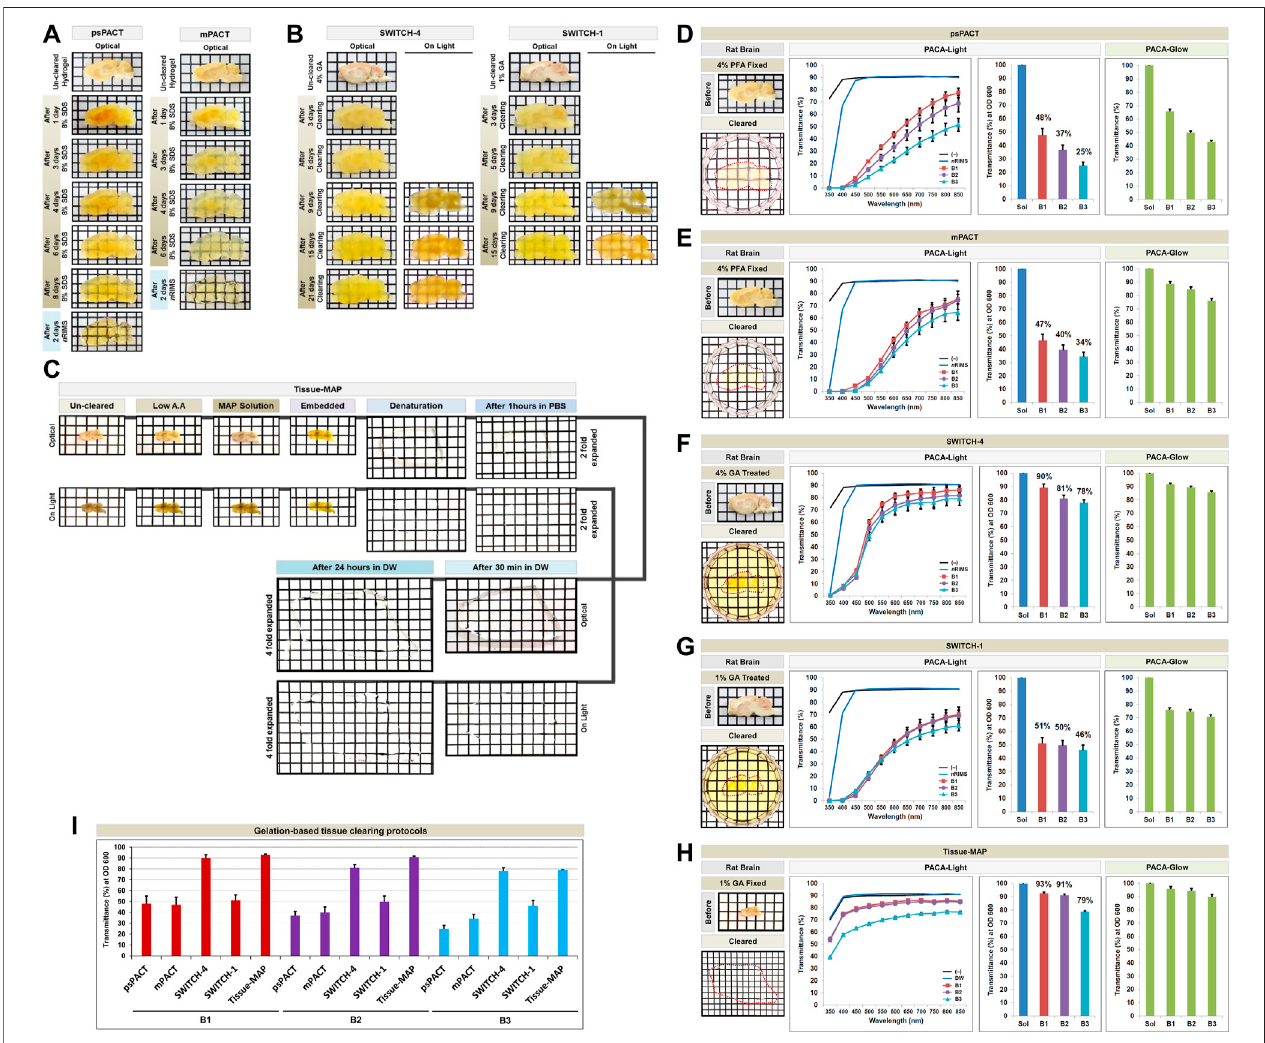
FIGURE 3 | Comparison of tissue clearing achieved with hydrogel-based tissue clearing protocols. Comparison of the optical clearing processes of PACTs (psPACT and mPACT) (A) , SWITCHs (SWITCH-1 and SWITCH-4) (B) , and Tissue-MAP (C) in rat brain samples (3 mm thickness). Comparison of clearing ef fi cacies of psPACT (D) , mPACT (E) , SWITCH-4 (F) , SWITCH-1 (G) , and Tissue-MAP (H) in rodent brain samples with both PACA-Light and PACA-Glow. Optical images showing samples after clearing (red dotted line), along with any changes in sample size upon tissue processing, are included (also Supplementary Figure S12 ). (I) Comparison of clearing ef fi cacies of hydrogel-based tissue clearing protocols. Three discs from three distinct brain regions (B1: prefrontal cortex and basal ganglia, B2: cerebralcortexandmidbrain/diencephalon,B3:cerebellum)weregeneratedandanalyzedforeachsample.Eachcolorlineandbarpointtoassessmentvaluesofempty (black)andrefractiveindexmatchingsolution(blue)ofeachprotocol,andthreedistinctregionsofthebraintheB1(square,red),B2(diamond,violet),andB3(triangle,sky blue). Green bars point to assessment values of glow light (unit) in dark. Results re fl ect three replicates of each experiment, and data are presented as the mean ± SD (standard deviation). The transparency of the cleared brain was evident against a patterned background (length:width (cid:1) 5 mm:5 mm).